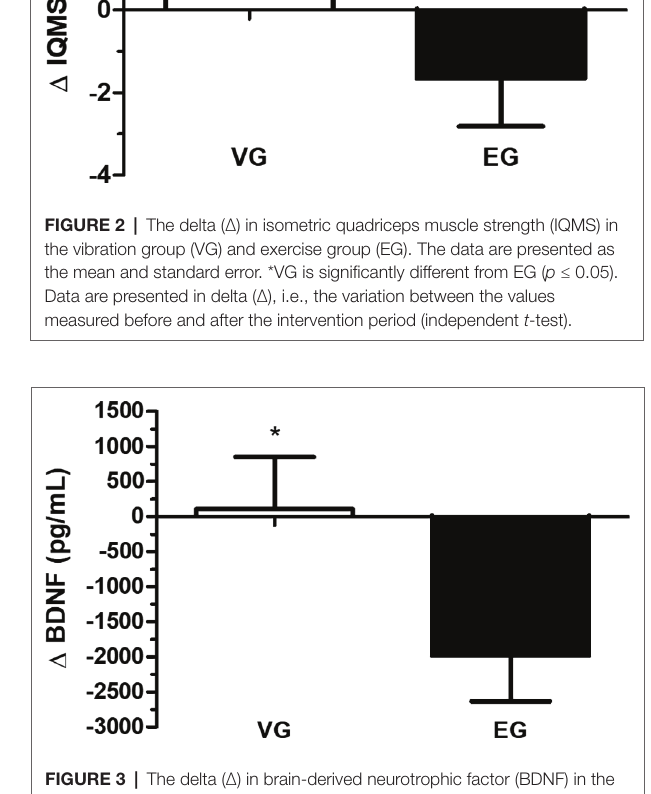
FIGURE 3 | The delta (Δ) in brain-derived neurotrophic factor (BDNF) in the vibration group (VG) and exercise group (EG). The data are presented as the mean and standard error. *VG is significantly different from EG ( p ≤ 0.05). Data are presented in delta (Δ), i.e., the variation between the values measured before and after the intervention period (independent t